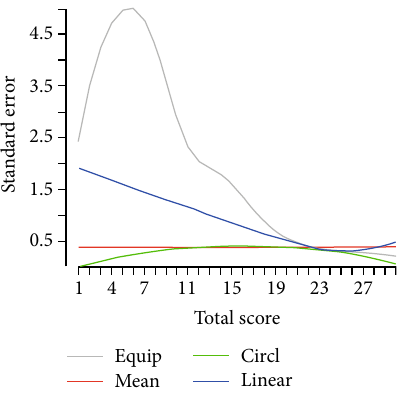
Figure 1: Standard errors graph of equating methods.